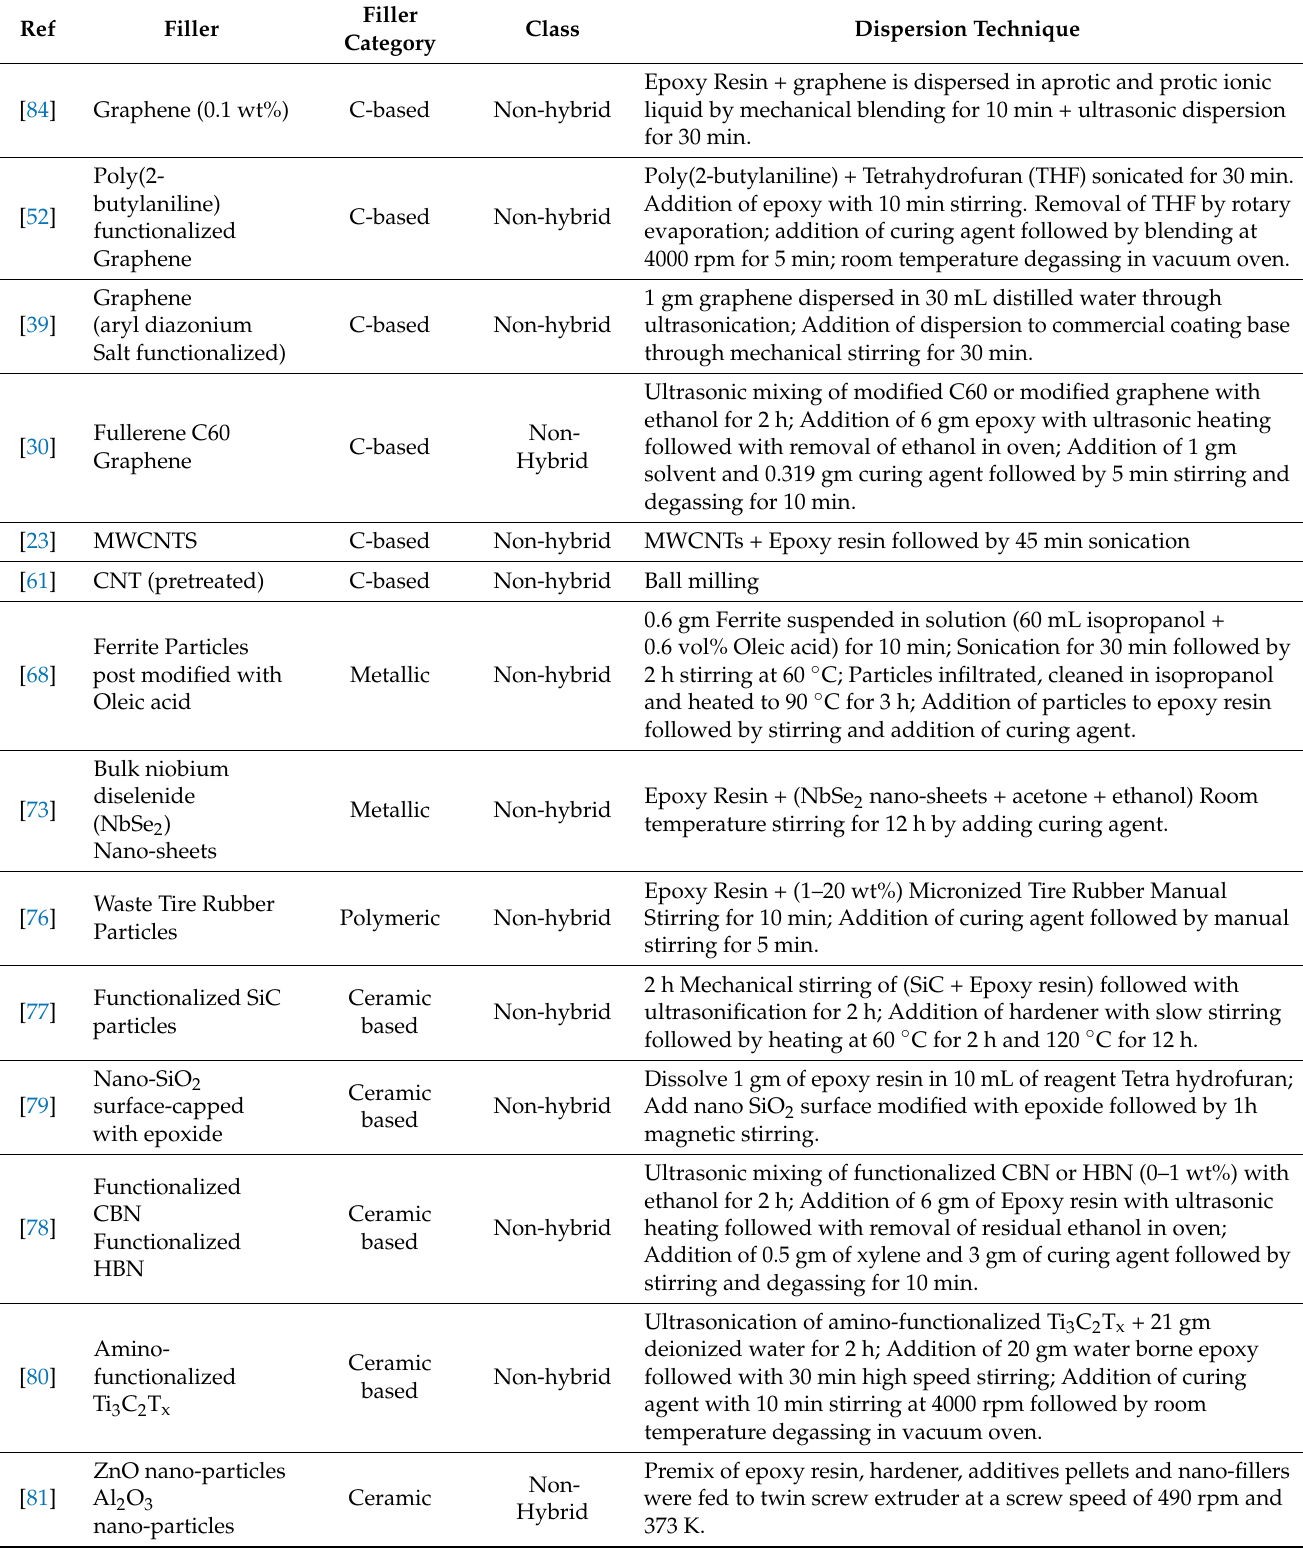
Table 3. Summary of various dispersion techniques used to uniformly disperse the nano-fillers in the epoxy